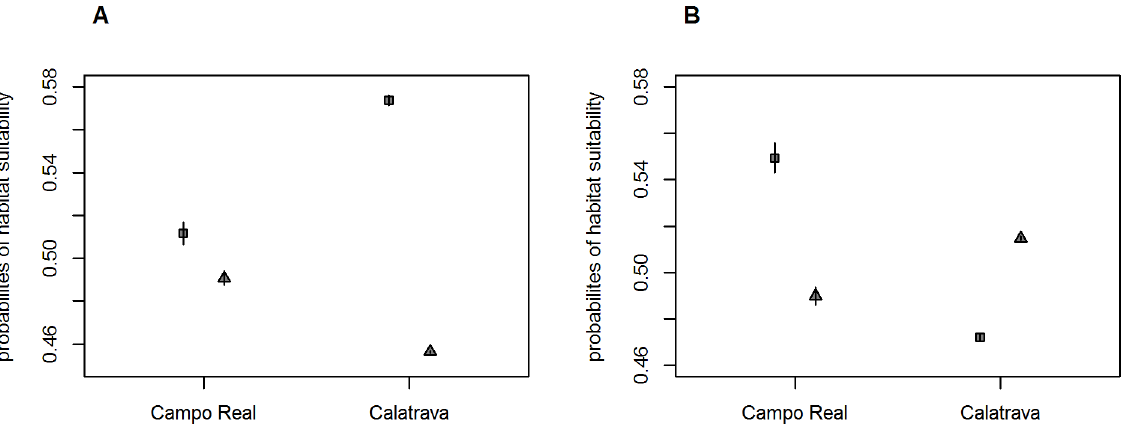
Figure 5. Probabilities of habitat suitability of coexistence and exclusive use areas. Mean and 95% confidence interval of probabilities of habitat suitability in coexistence and exclusive use areas for the Little (A) and Great Bustards (B) in Campo Real 2011 and Calatrava 2008. Student t tests were performed with the residuals of the polynomial regression although original probabilities are shown for the sake of interpretation. Probability means of coexistence areas are represented as triangles and probability means of exclusive use areas are represented as